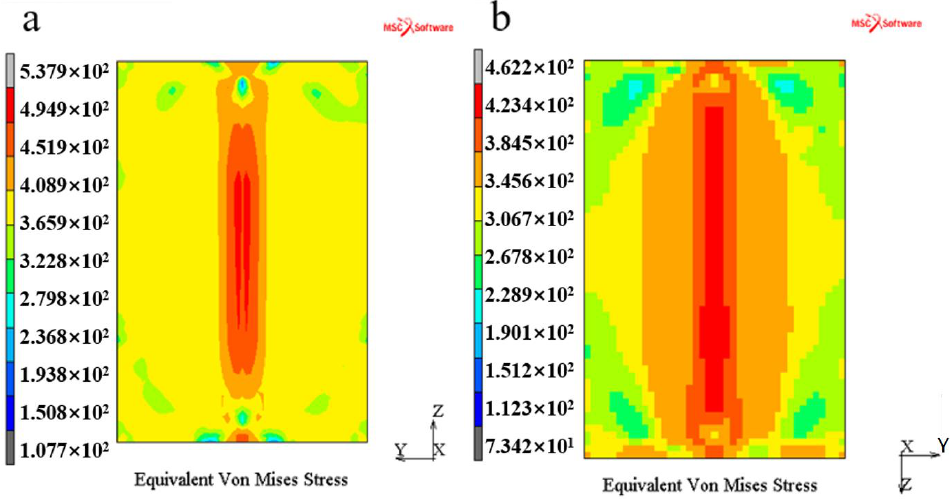
Figure 12. Equivalent stress. ( a ) one-time welding, ( b ) pre-heating, welding and post-heating.